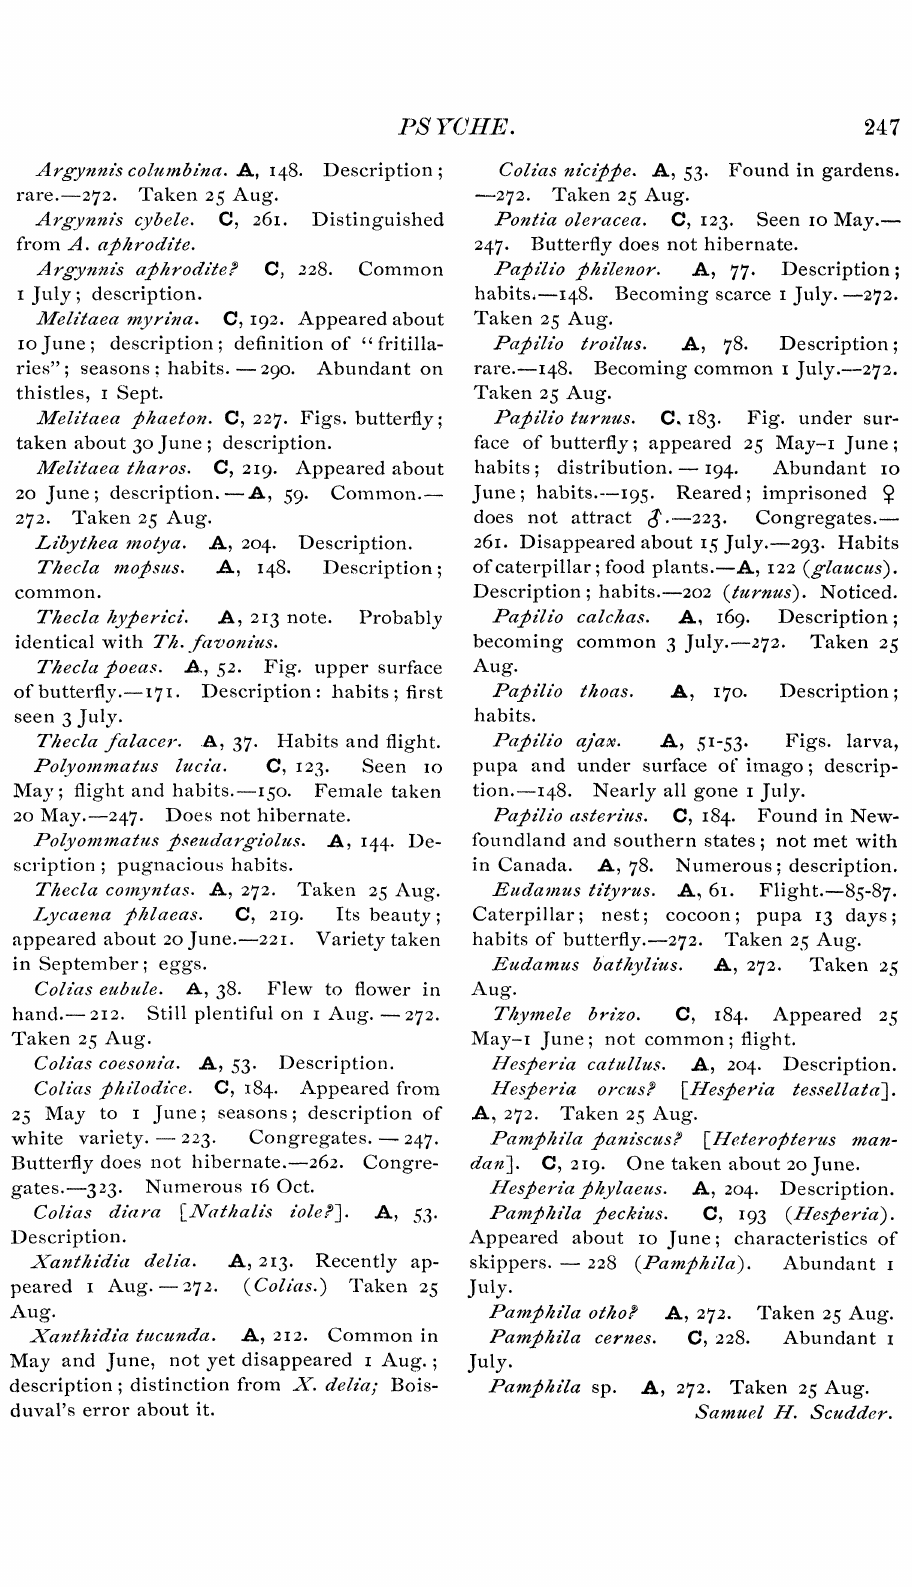
k, 272. Taken 25 Aug. Samuel It.